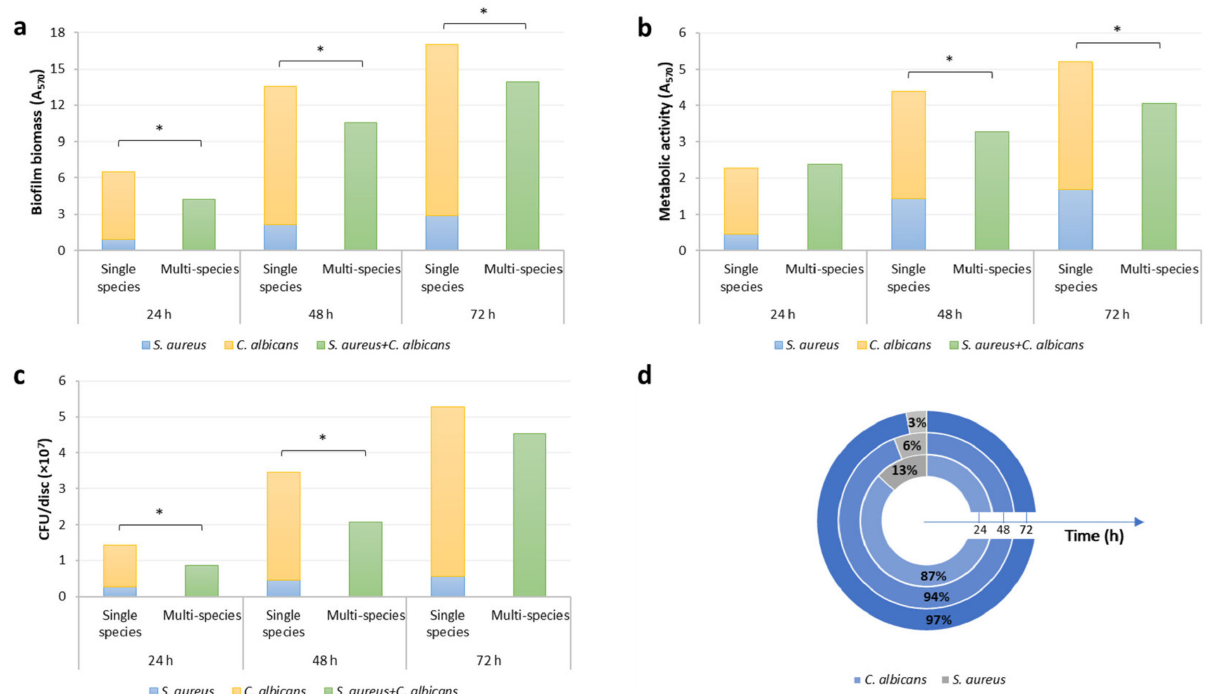
Figure 1. Biomass ( a ), metabolic activity ( b ) and cell viability ( c ) of C. albicans ATCC ®® 10231 and S. aureus ATCC ®® 6538 single- and multi-species biofilm formed on untreated titanium discs. Results were obtained by mean CV staining, MTT reduction assay and viable cell counting respectively. Single- and multi-species cultures were grown in YNBD + 10% FBS and were evaluated after 24, 48 and 72 h of incubation. The multi-species biofilm composition ( d ) was determined by viable cell counting on selective agar media (Mannitol Salt Agar, selective for Staphylococcus, and Sabouraud Chloramphenicol Agar, selective for fungal growth) at the same time-points (24 h: internal pie; 48 h: middle pie; 72 h: external pie). * p <